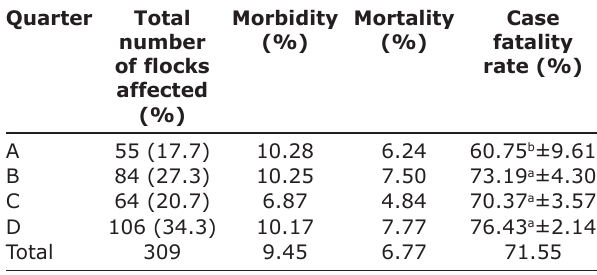
Table-2: Quarter wise distribution of percent morbidity, mortality, case fatality rate due to FT in broiler chicks in some parts of Haryana during 2011-2013.